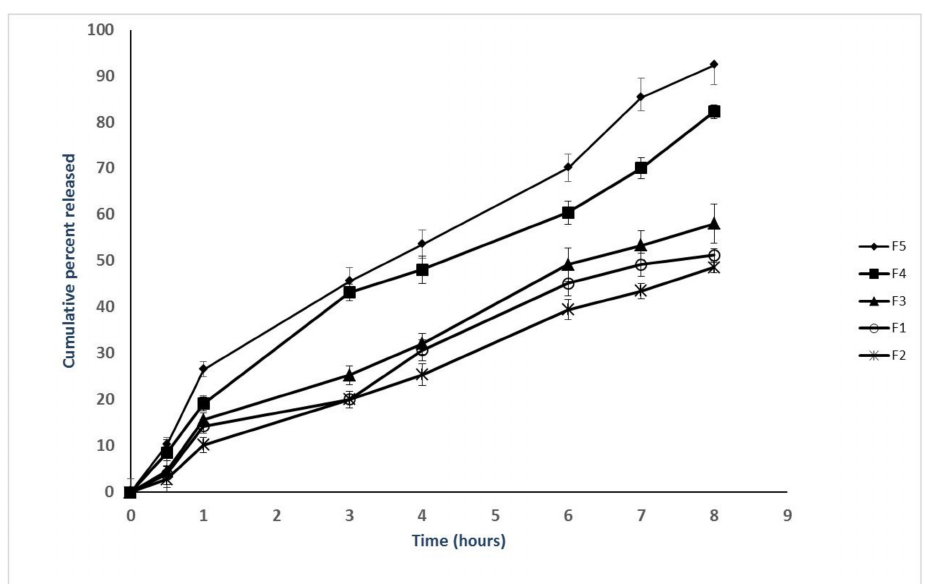
Figure 2. In vitro release of flavonoids from the prepared propolis-encapsulated liposomes (F1–F5) in phosphate-buffered solution containing 0.5% tween 80 to maintain sink condition (PBS, pH 7.4, 37 ◦ C). The results are represented as the means ± SD ( n = 3).